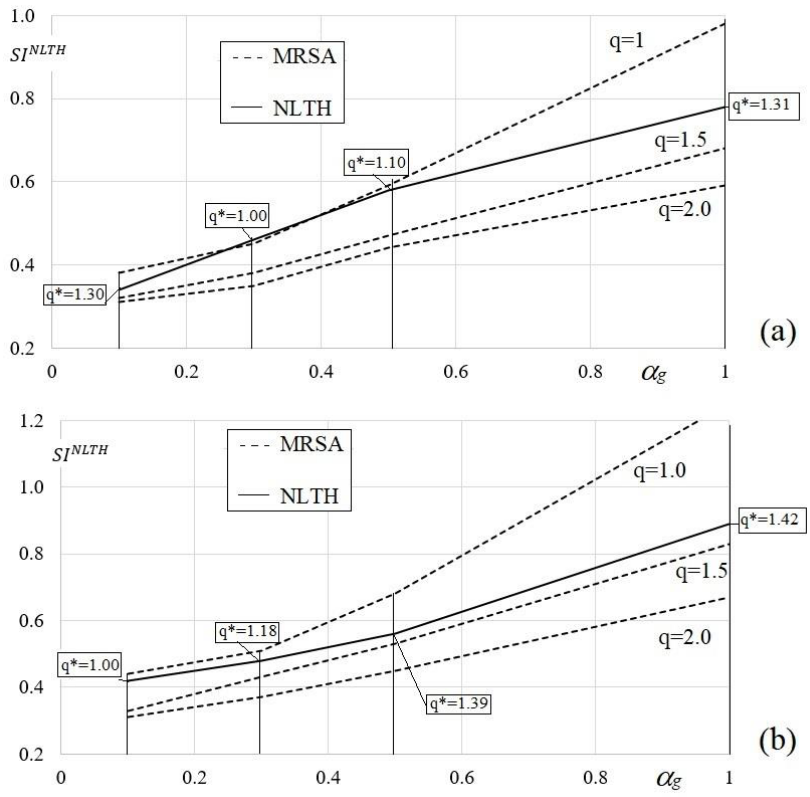
Figure 14. Comparison between MRSA and NLTH in terms of max safety index (SI) for: ( a ) Zone_1 and ( b ) Zone_2.